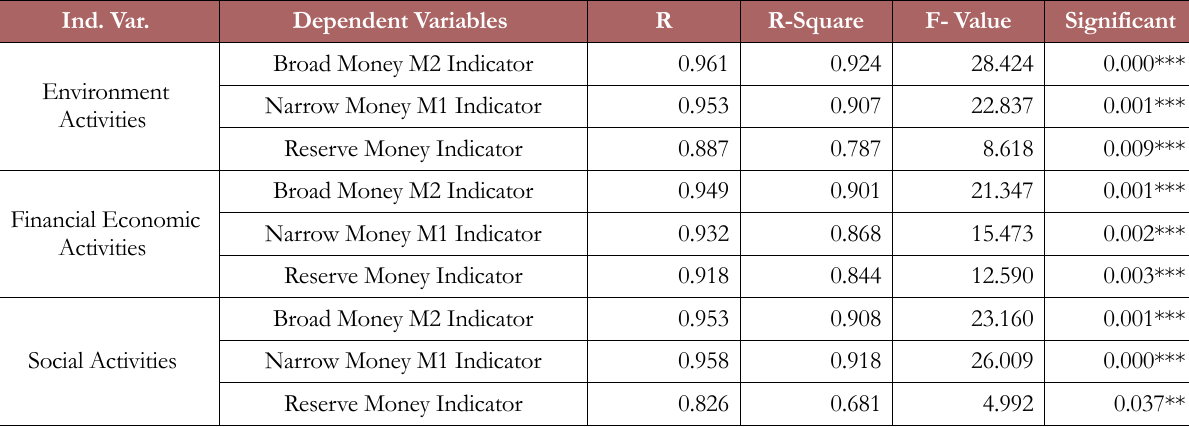
Table 4. Multiple regression analysis of all variables of green logistics activities and each monetary expansion